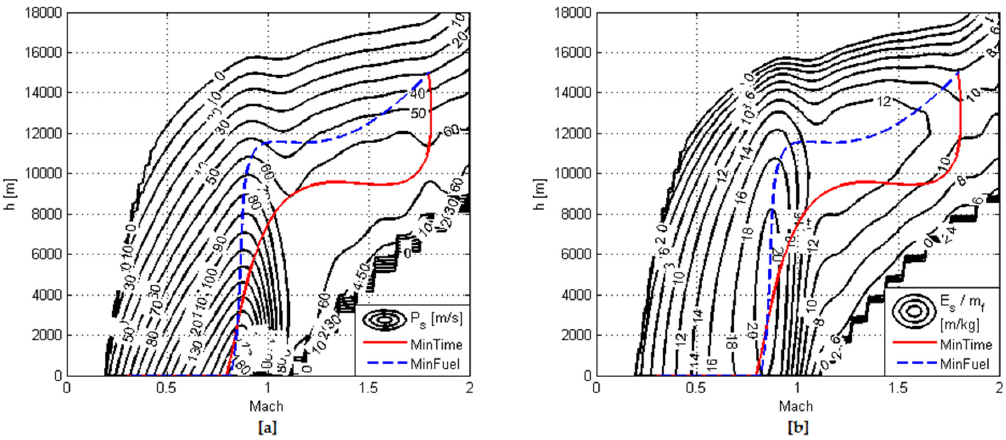
Figure 17. Case B, Configuration C1; Minimum Time and Minimum Fuel climb paths, plotted over contours of: Specific Excess Power (m/s) ( a ); and Energy Efficiency (m/kg) ( b ).